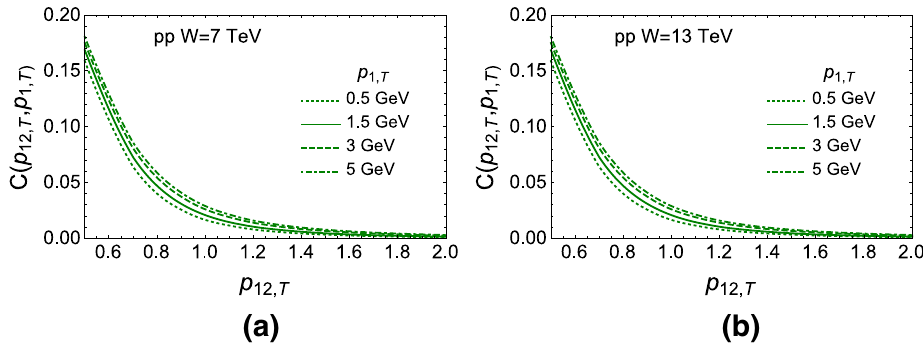
Fig. 5 Correlation function C ( L c | (cid:6) p T 2 − (cid:6) p T 1 | ) versus (cid:6) p 12 , T ≡ (cid:6) p 1 , T − (cid:6) p 2 , T at different values of p 1 , T and energies W = 7TeV ( a ) and W = 13TeV ( b )